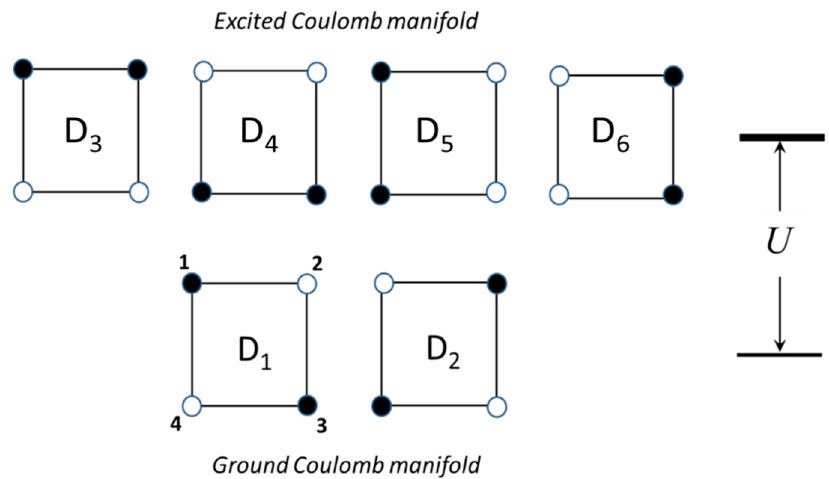
Figure 1. Numeration of the sites of the square-planar tetrameric cluster with two mobile electrons, two antipodal distributions denoted as D 1 and D 2 and four excited neighboring distributions D 3 … D 6. The sites occupied by the extra electrons are shown by black balls, the spin cores are indicated as white balls.